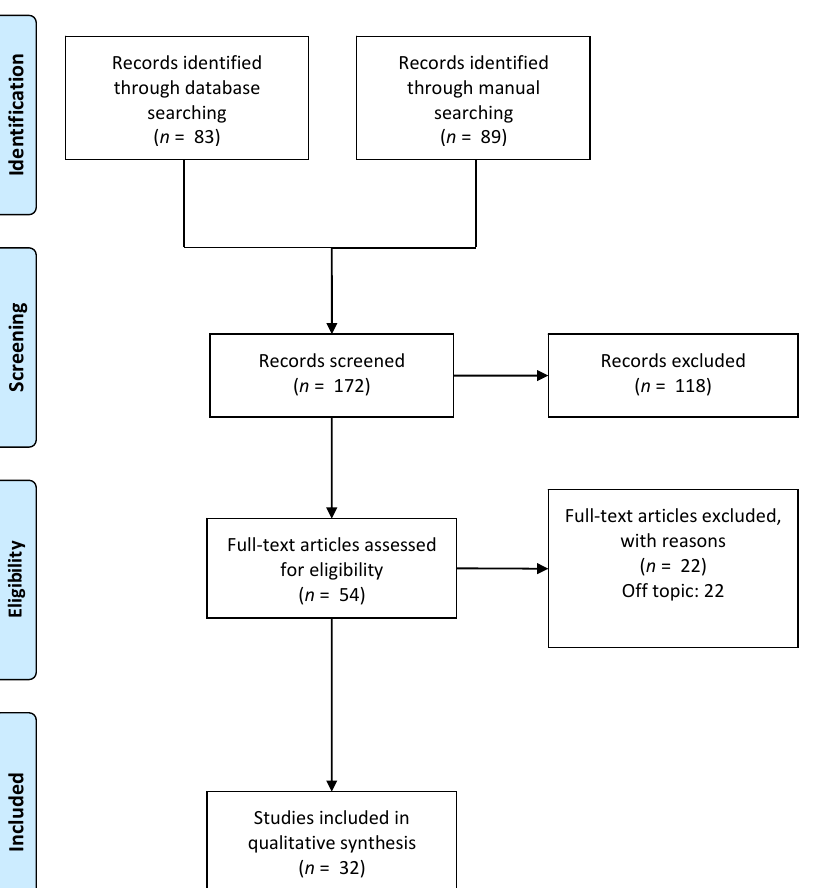
Figure 5. Selection of studies for the systematic review. Table 1. Summary of the studies included in the systematic review.